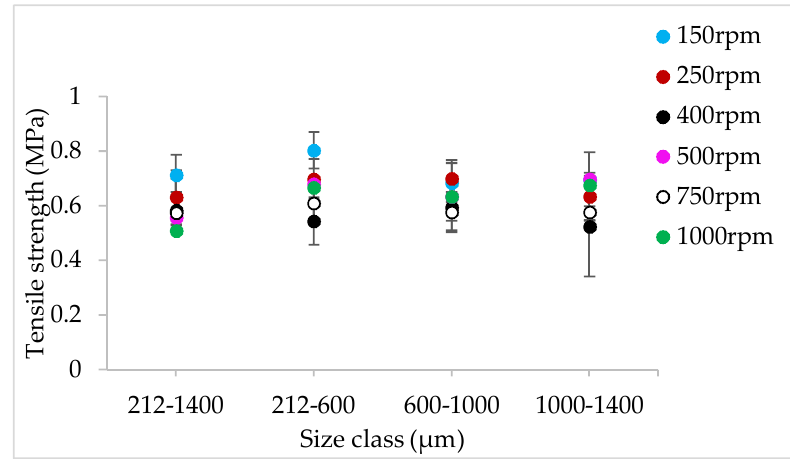
Figure 9. Tensile strength of tablets of lactose granules produced at varying screw speed at SFL—0.041 and PFN—1.71403 × 10 −5 (L/S 0.048).